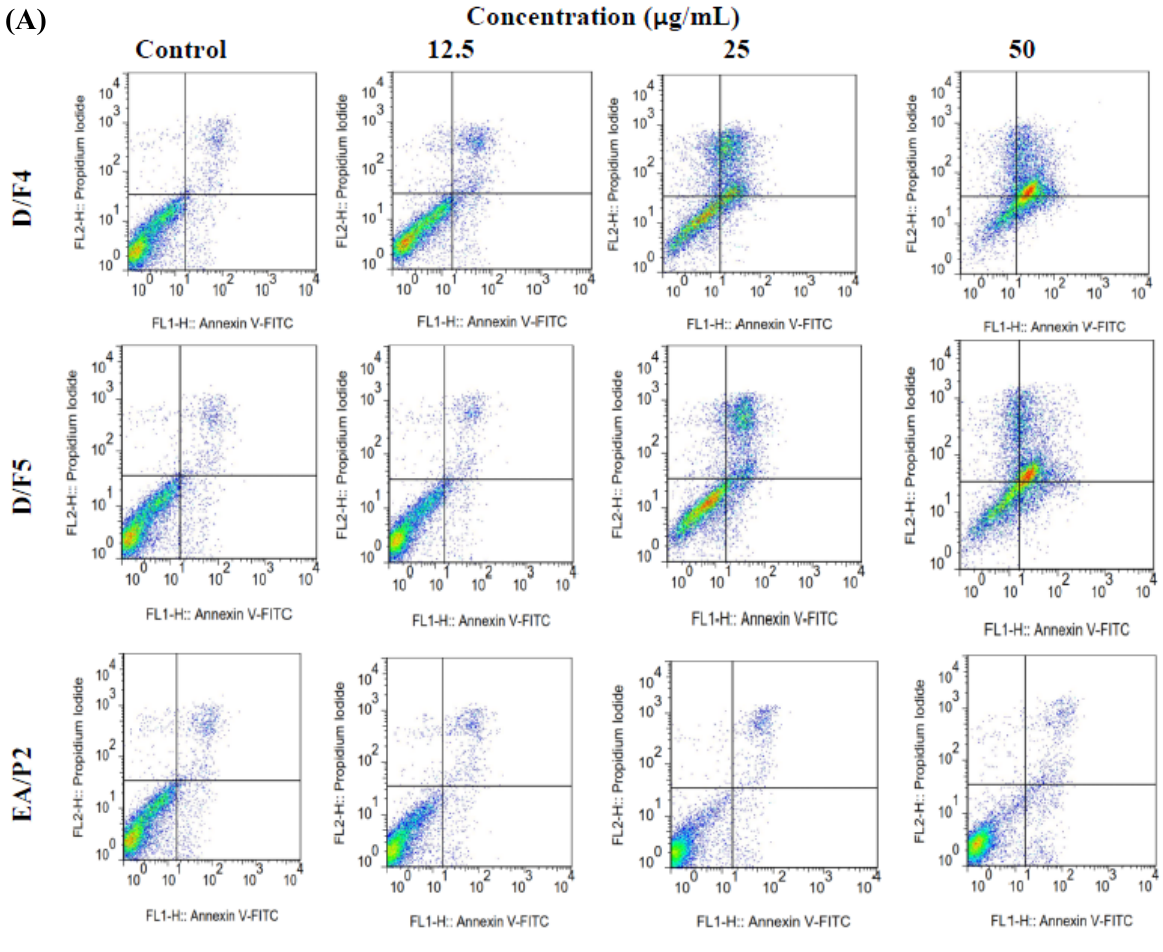
average value of three independent experiments ±